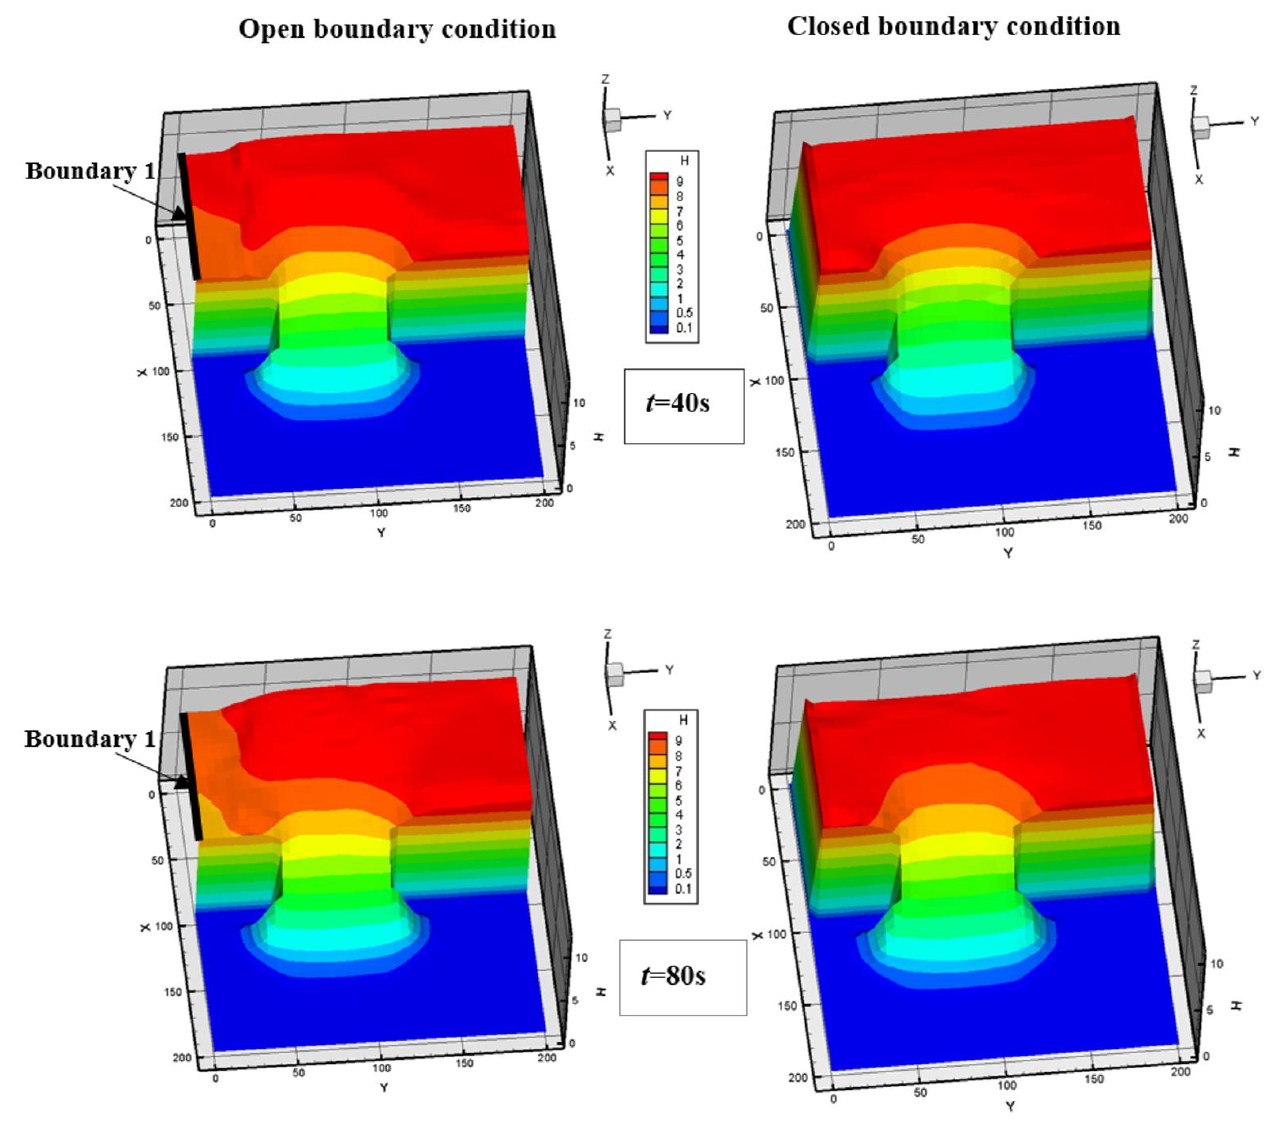
Figure 11. Comparison of the computational dam break configuration at times t = 40 s ( upper ) and t = 80 s ( lower ) with open ( left ) and closed ( right ) boundary conditions (unit: m).